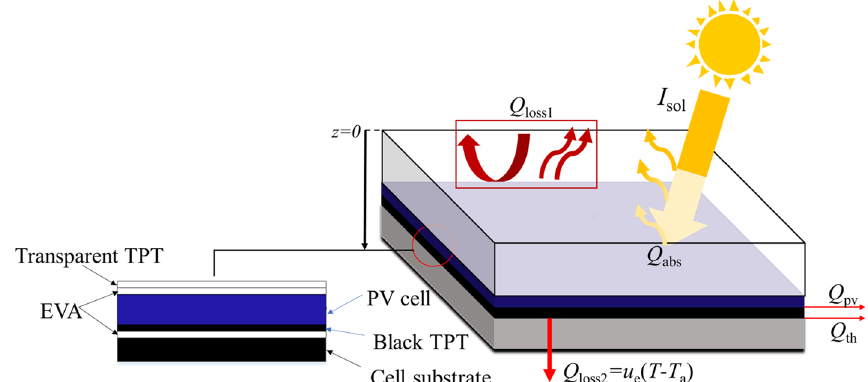
Fig. 7 The energy flow process of the